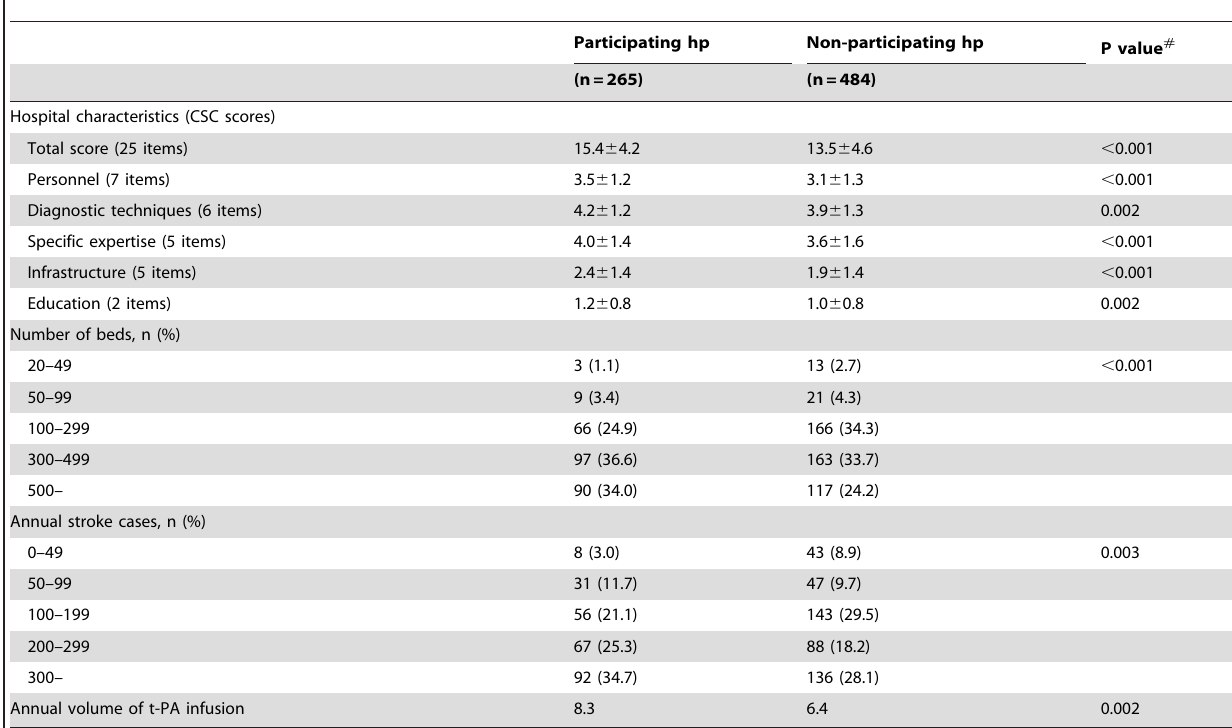
Table 2. Demographics of the study cohort according to the Diagnosis Procedure Combination (DPC) discharge database study in a comparison of hospitals that agreed to participate in the present study and those that did